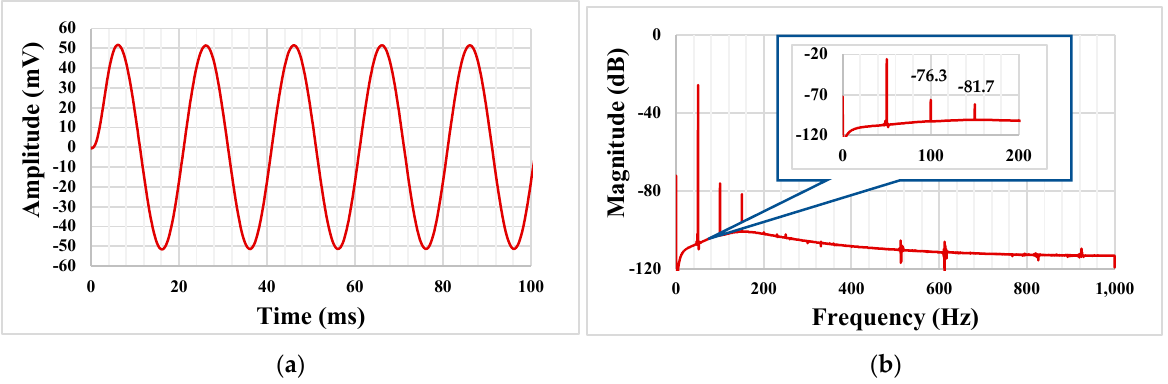
Figure 13. The transient response of the LPF ( a ) and its spectrum ( b ). Table 3 shows a comparison of the proposed filter with the others [26–28]. It is evi- dent that the proposed filter offers the largest amount of filtering functions with a mini- mum count of active elements, and the lowest voltage supply, and is the only one with nanopower consumption. All these facts confirm the usability of the multiple-input G m stage in filter applications mainly by means of reducing the count of active blocks and power consumption. The figure of merit (FoM) is also presented, where a lower FoM im- plies the better performance of the filter. Table 3. Comparison with other filters. This Work